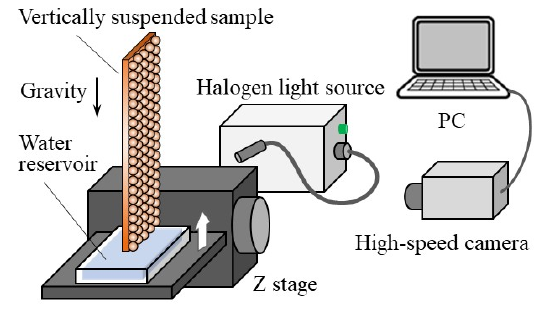
Figure 2. Schematic of rate-of-rise experiment setup.